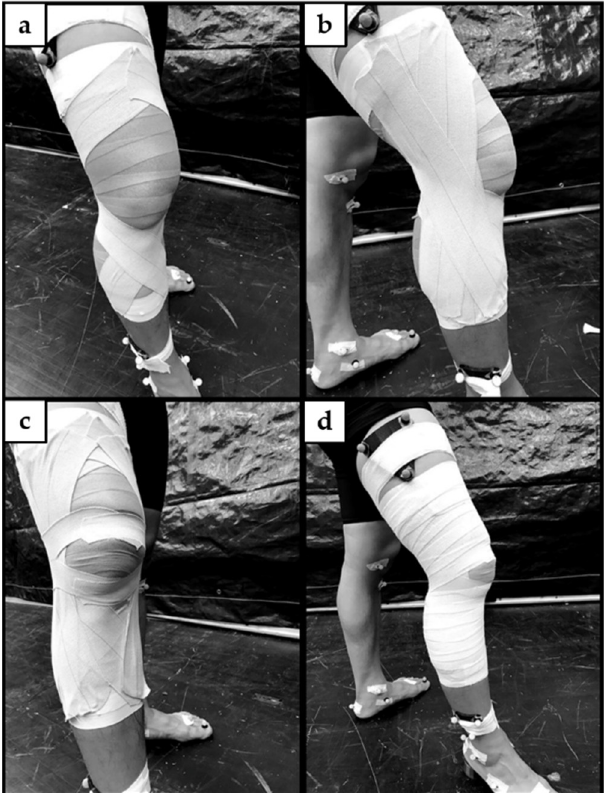
Figure 1. Anterior cruciate ligament protective taping techniques comprise three parts: ( a ) Rotatory taping strips. ( b ) Collateral ligament knee taping strips. ( c ) Patella taping strips. ( d ) Covered with 2-inch elastic adhesive light wrap tape from the bottom to the